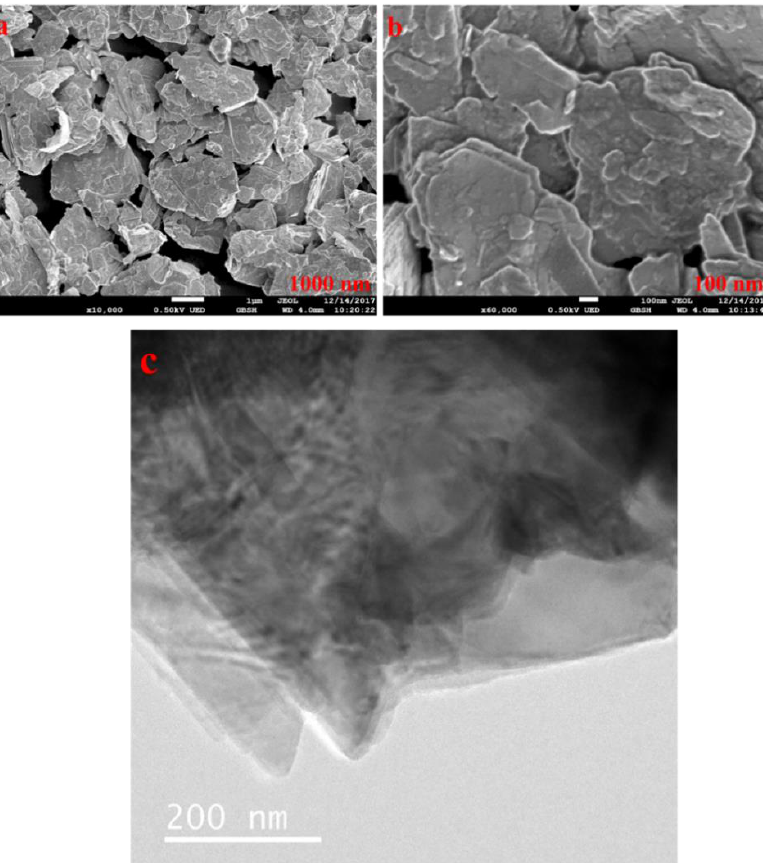
Figure 3. ( a , b ) FESEM image of MoS 2 at different magnifications and ( c )